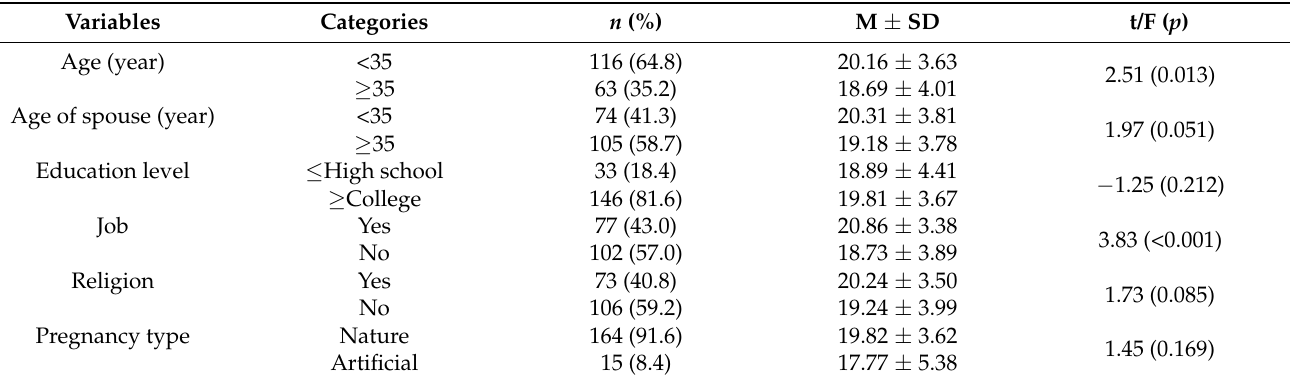
Table 3. Maternal Postpartum Quality of Life according to General